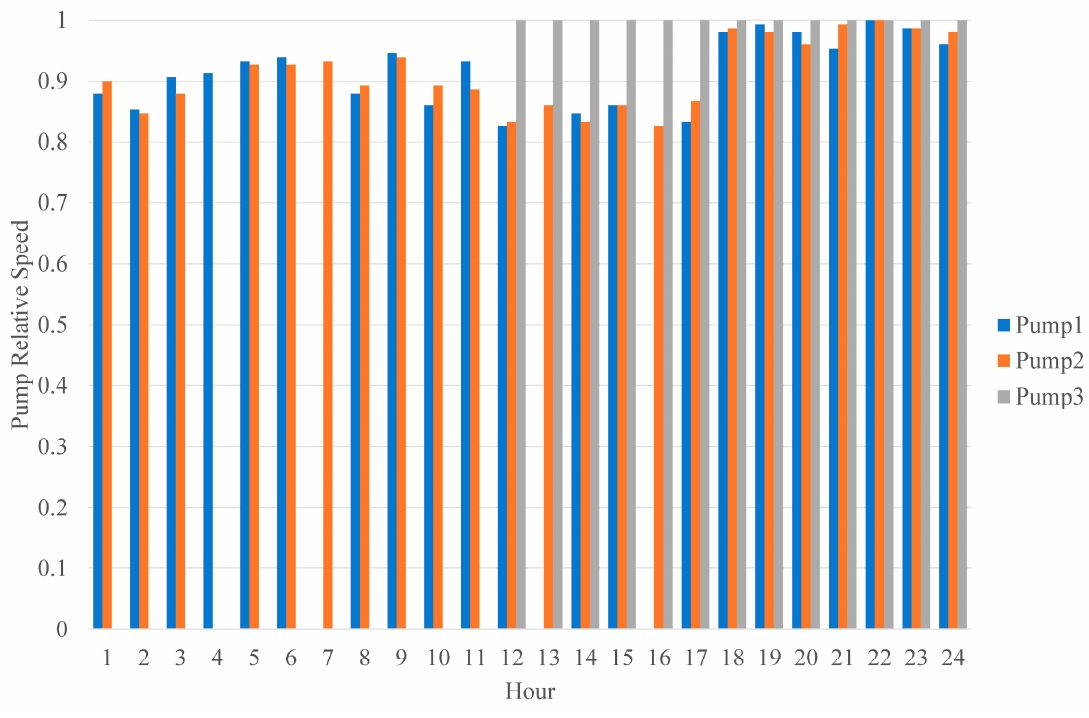
Figure 6. Hourly sequence of pumps relative speeds for Case 1.